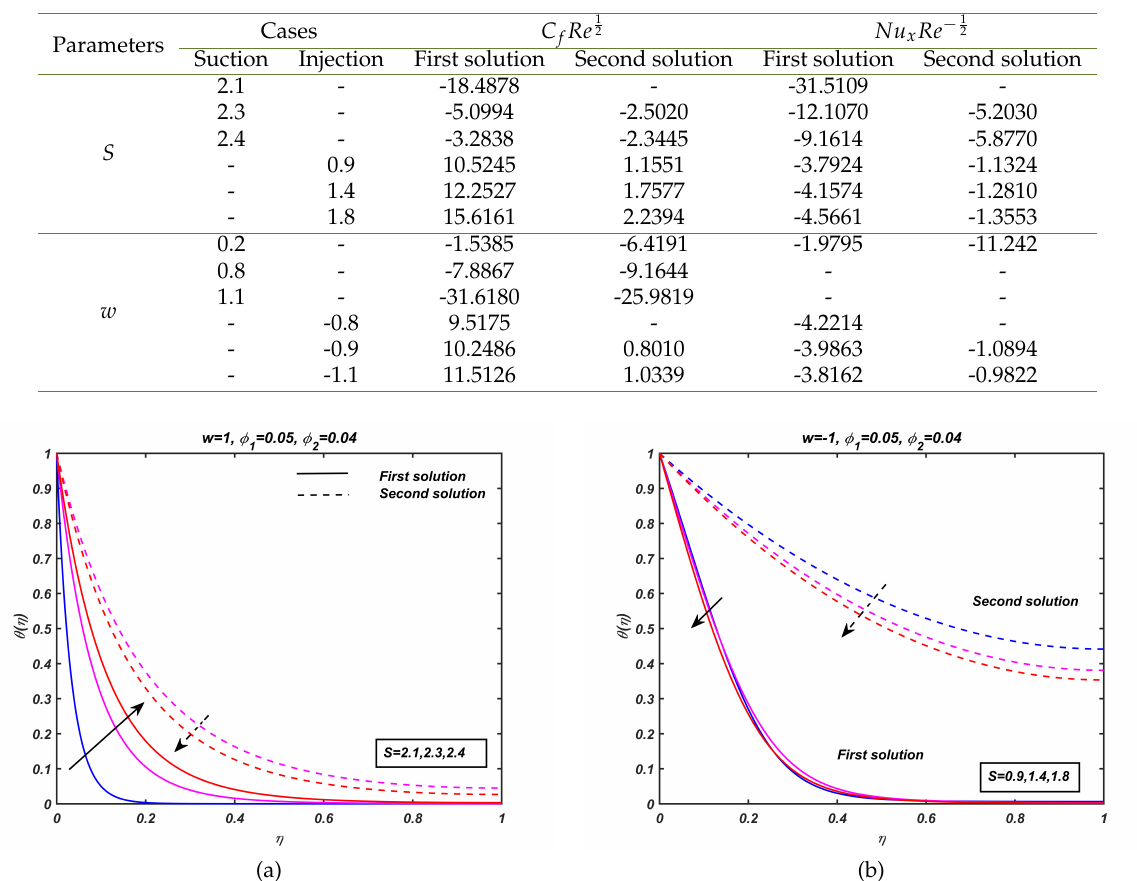
Table 3. Values for local skin friction, C f Re 1 2 and Nusselt number Nu x Re − 1 2 for various number of S and w Parameters